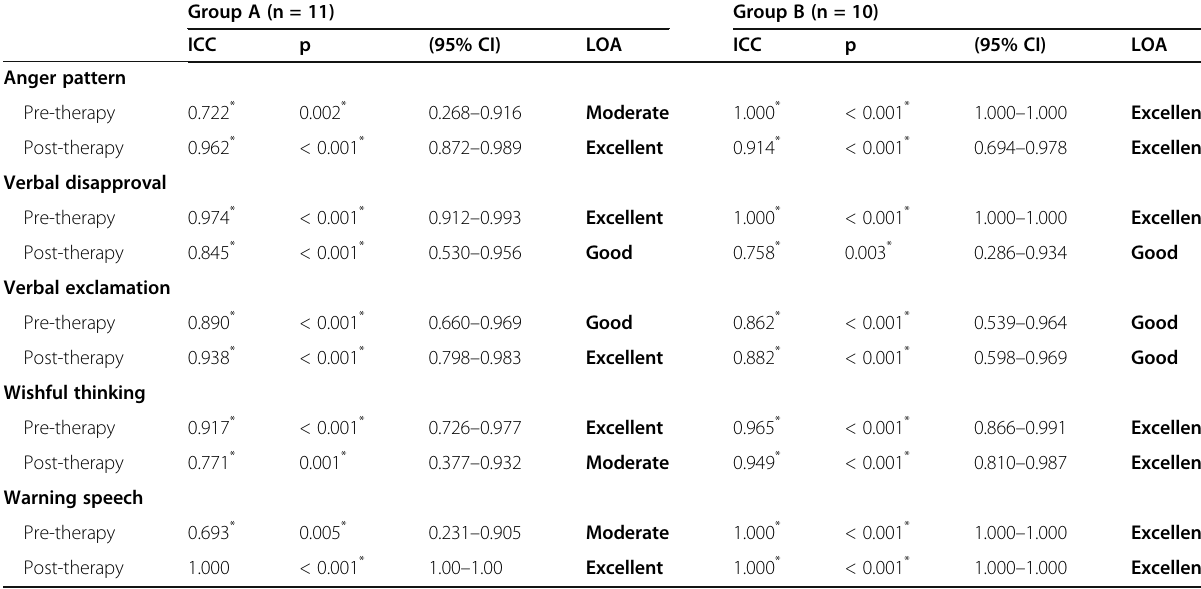
Table 5 Comparison between rater 1 and 2 in subjective